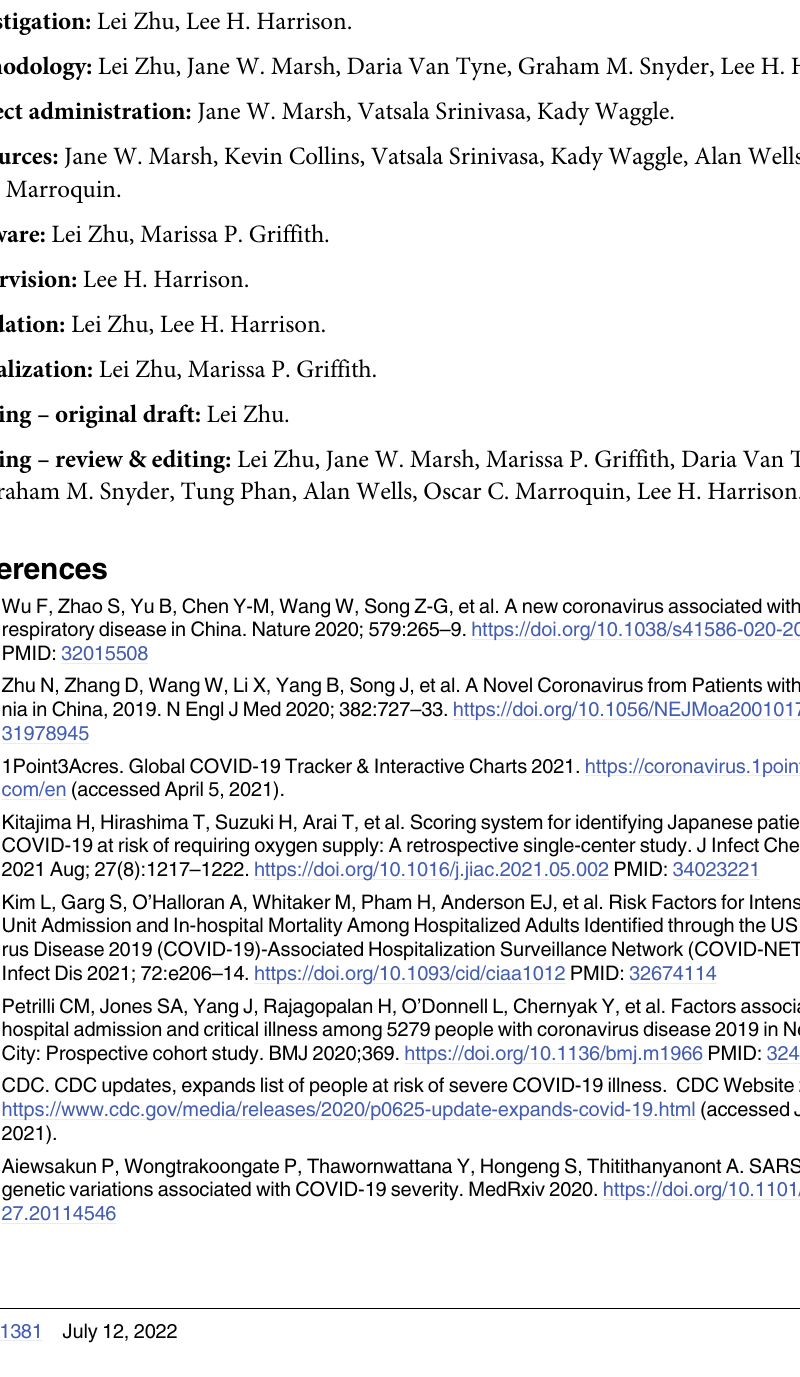
S1 Fig. Distribution of SARS-CoV-2 lineages over time (March 2020 to May 2021), by